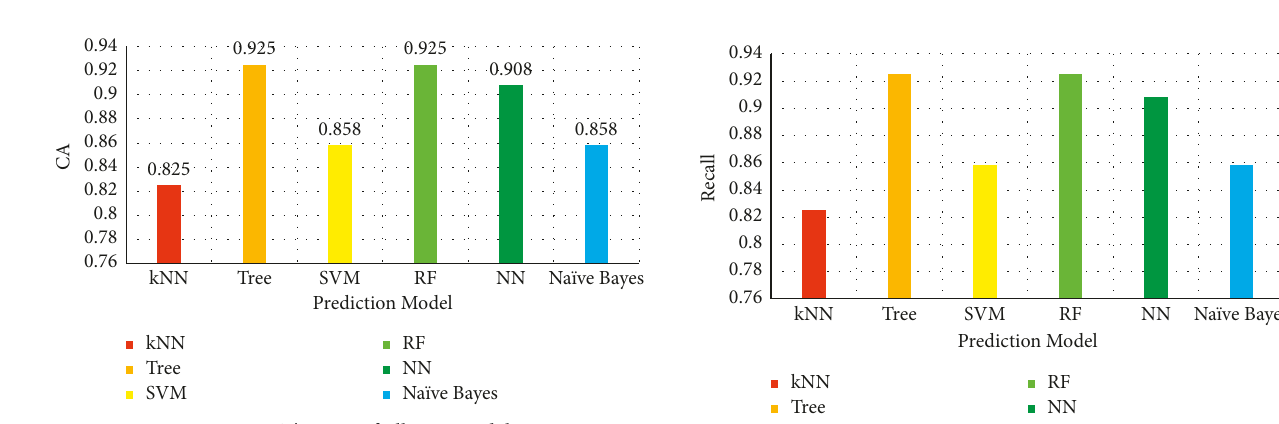
Figure 12: The precision of all ML models.